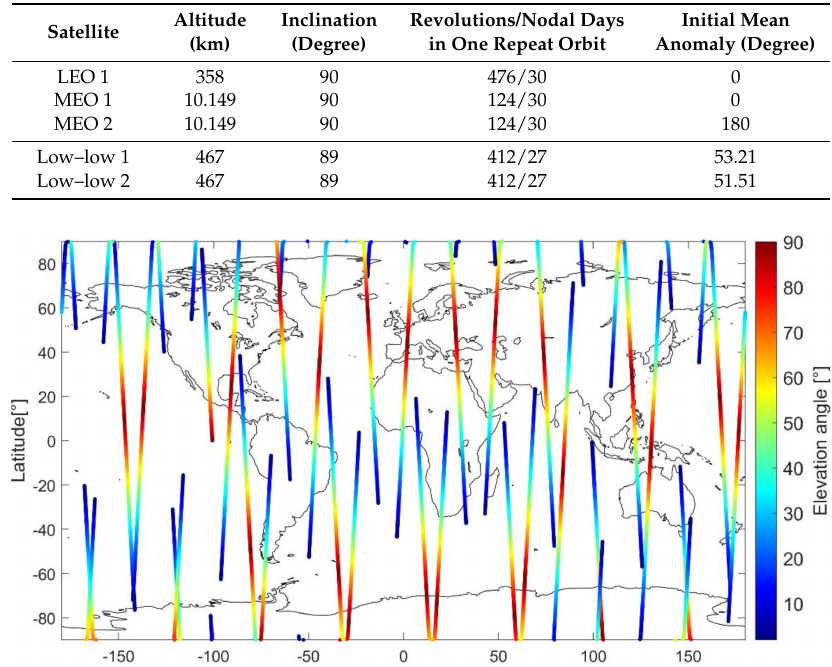
Table 1. Orbit parameters for satellite constellations.